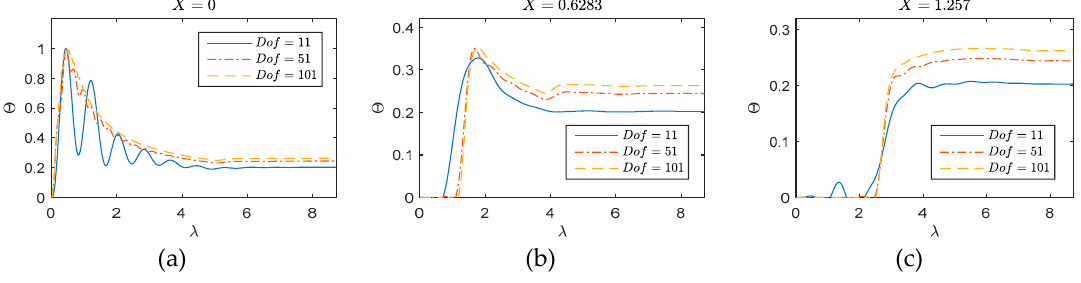
Figure 3. Performance and convergency of finite element method (FEM) on one-dimensional issue ( a ) X = 0; ( b ) X = 0.6283; ( c ) X = 1.257.